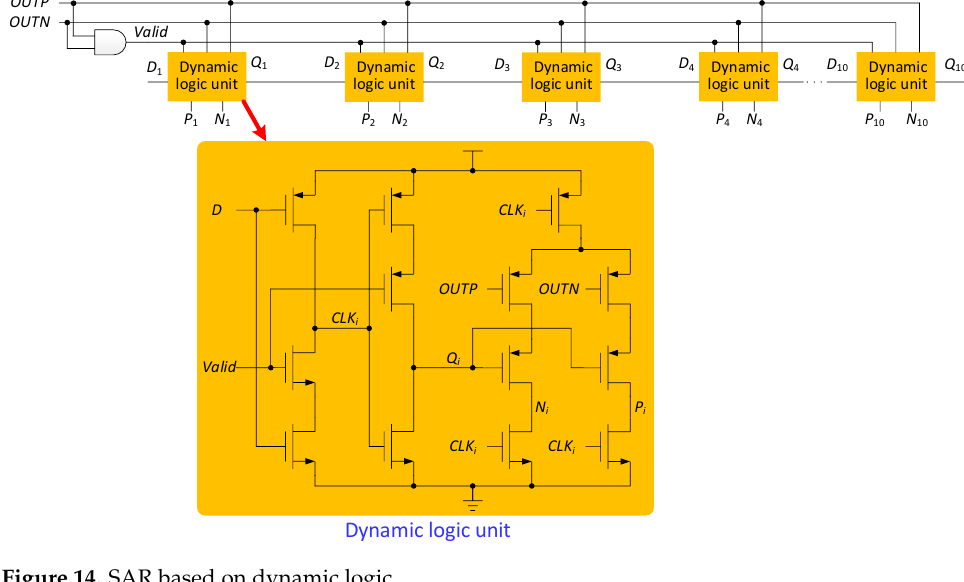
Figure 14. SAR based on dynamic logic. Table 6. The resolution settings of SAR logic. MO1